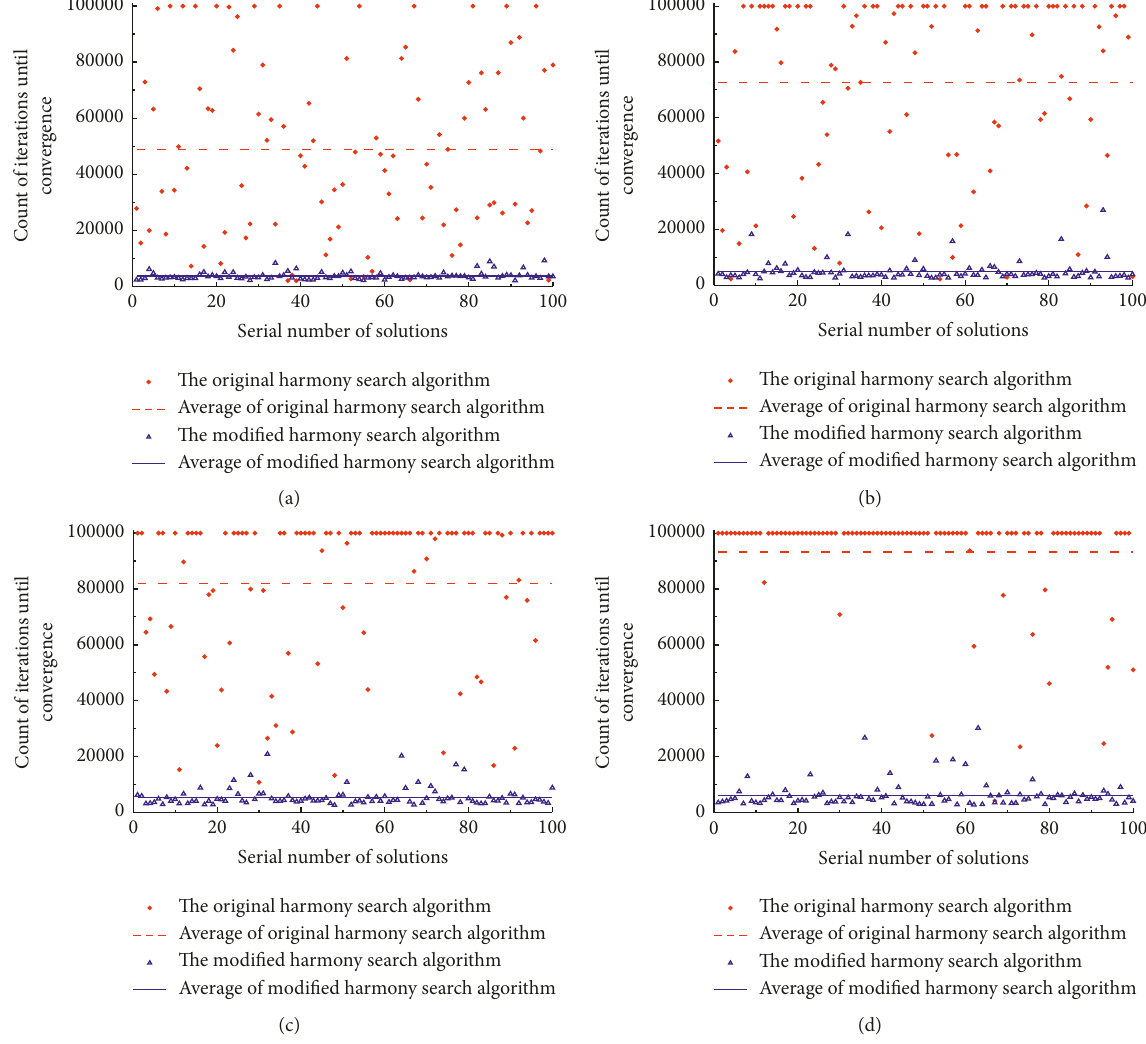
Figure 13: The convergence efficiency of original and modified harmony search algorithms. (a) Relative converge tolerance 20%, (b) relative converge tolerance 10%, (c) relative converge tolerance 5%, and (d) relative converge tolerance 2%. Table 7: Mean and standard deviation of the count of iterations at convergence for different algorithms. Modified harmony search Relative converge tolerance (%)